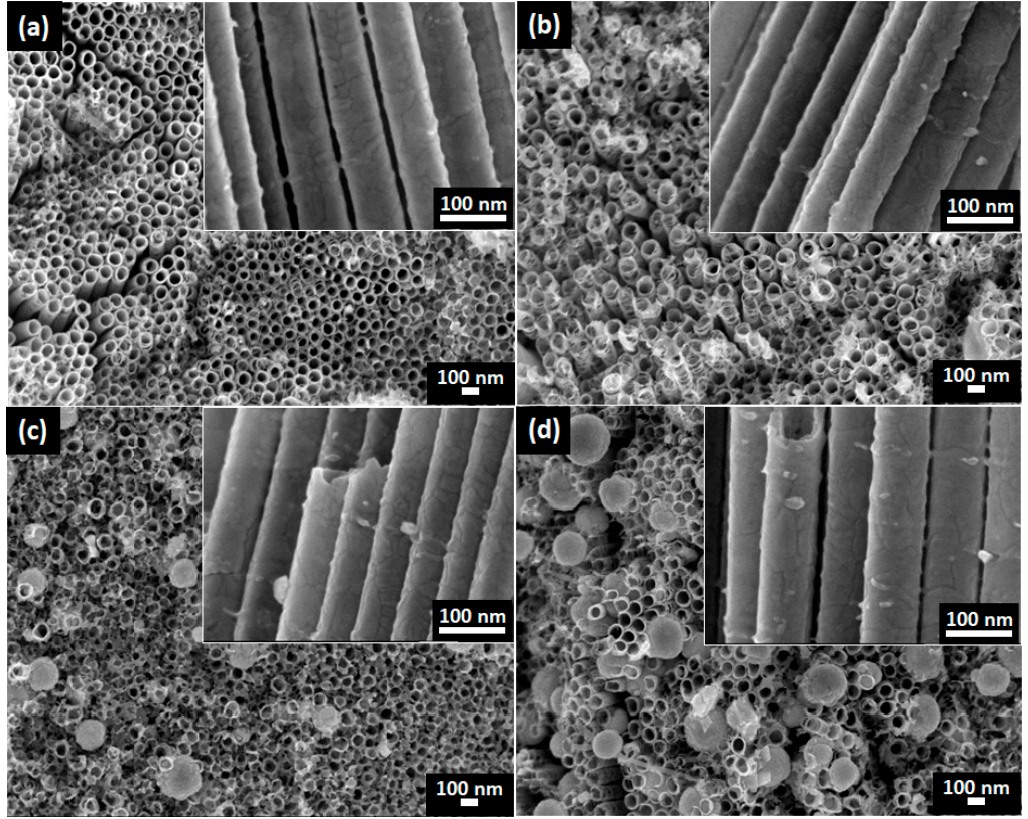
Figure 2. FE-SEM images of CdSe–TiO 2 nanotube thin films deposited at chemical batch temperatures of: ( a ) 20 °C, ( b ) 40 °C, ( c ) 50 °C, and ( d ) 60 °C, and the inset is cross-sectional view. Table 1. An average at % of CdSe–TiO 2 nanotube thin films deposited at different chemical bath temperatures, obtained by energy dispersive X-ray spectroscopy (EDX) analysis .